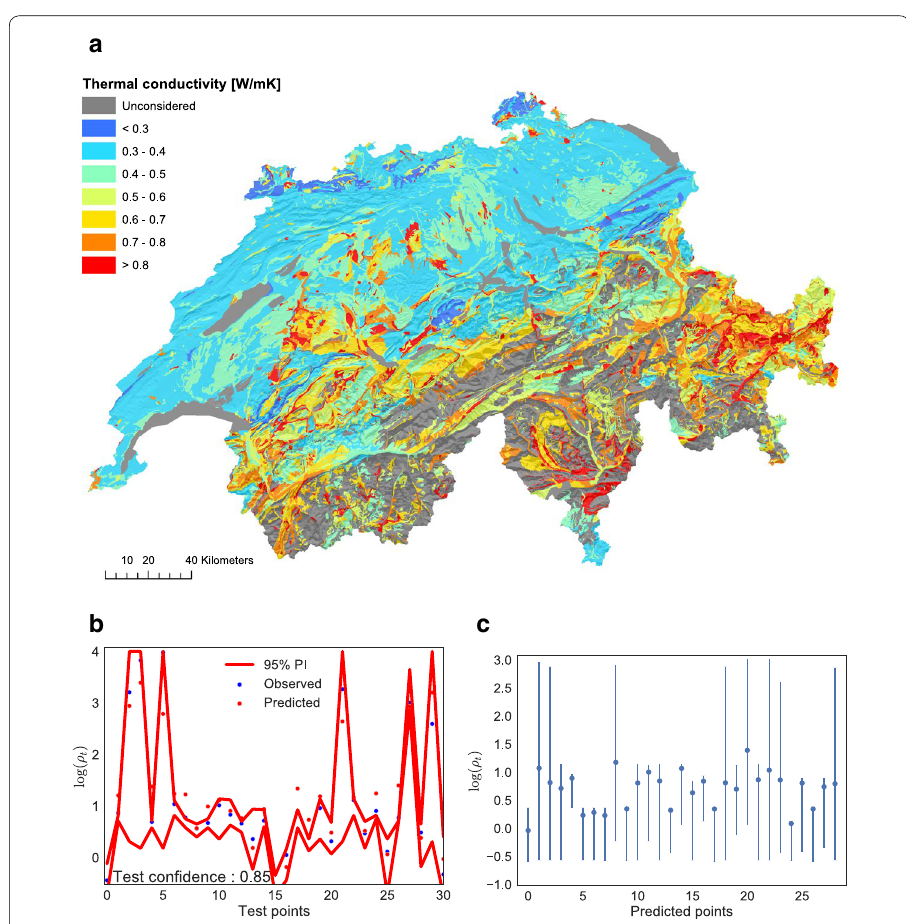
Fig. 13 Thermal conductivity map as estimated in the study with visualization of PIs (with 95% confidence) both in the test set and for new points. a Thermal conductivity ( (cid:31) ) map; b PIs in the test set for the label variable used ( log (ρ t ) where ρ t is the thermal resistivity) while training the RF model; c PIs for 30 random unknown points for the same label